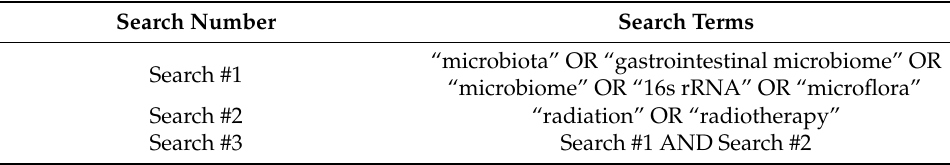
Table 3. Literature search algorithm—Cochrane